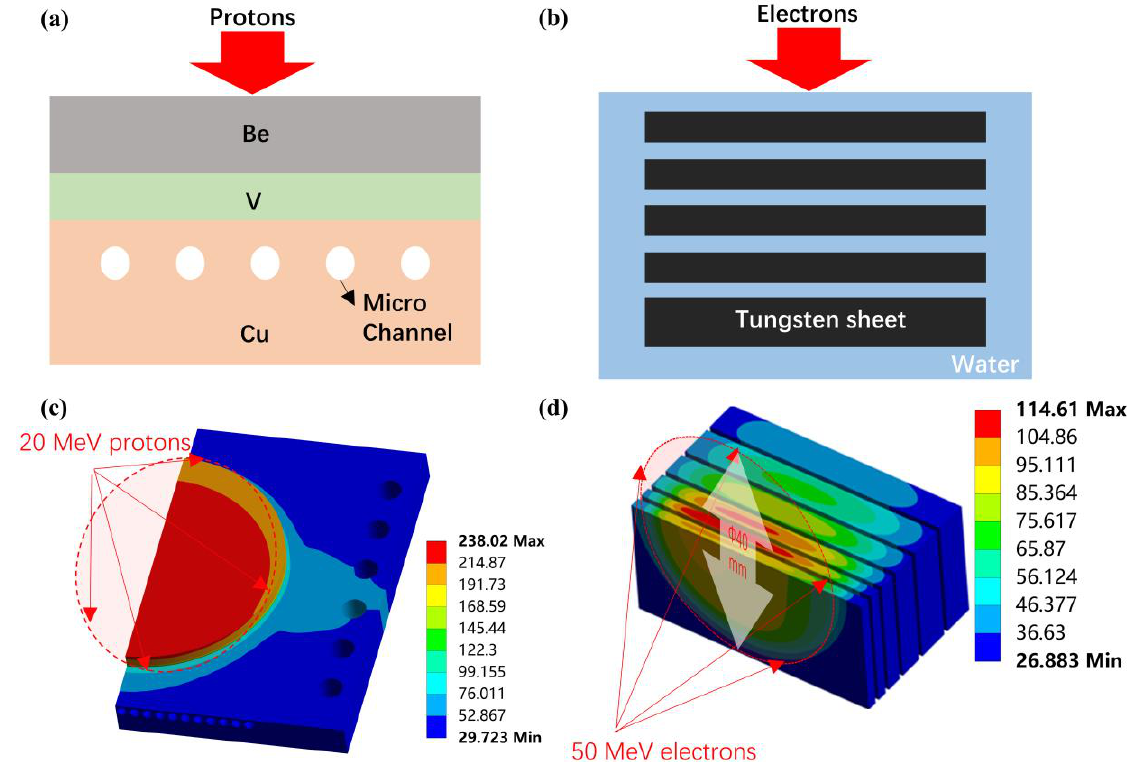
Figure 3. The typical target design: ( a ) multilayer structure for proton and ( b ) multidisc structure for electron; ( c ) the result of the 3D thermal-hydraulic simulation for 20 MeV proton-accelerator target and ( d ) 50 MeV electron-accelerator target.